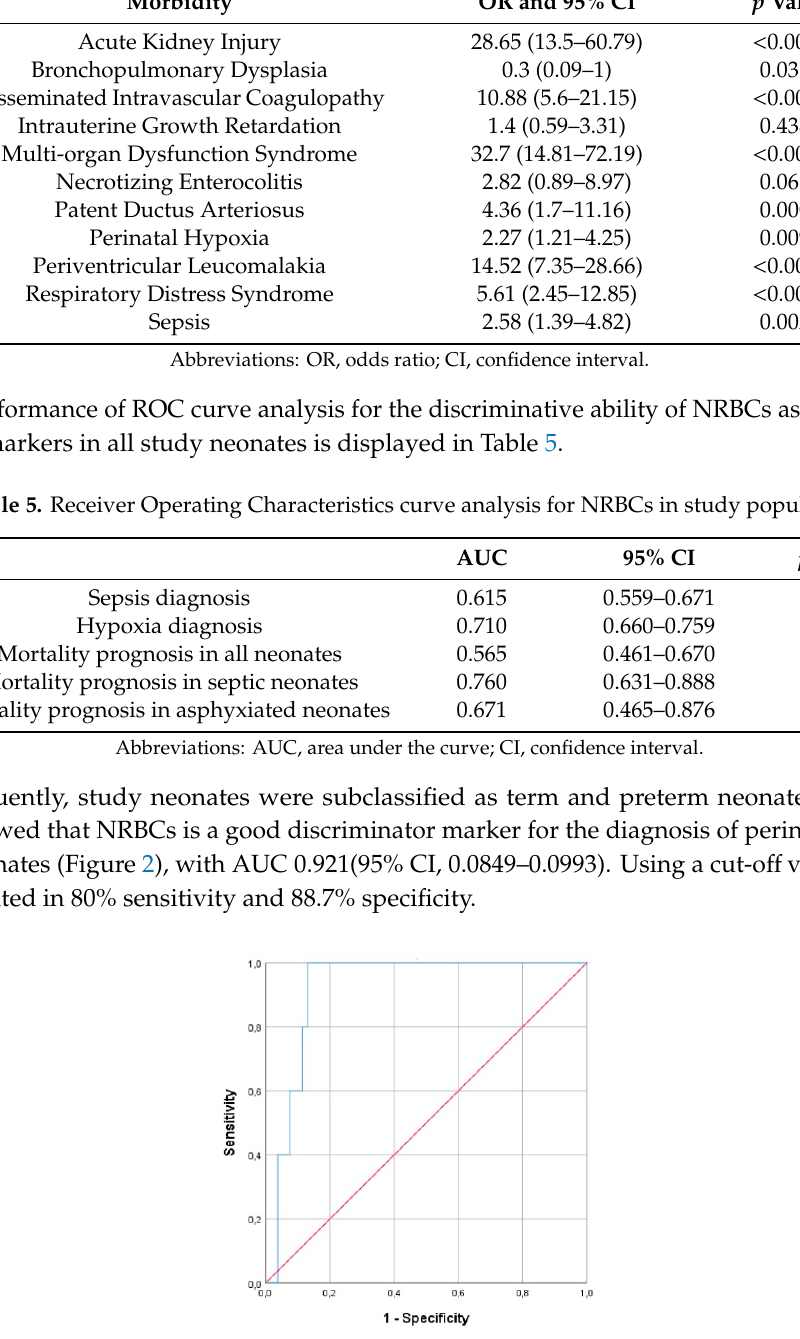
Figure 2. Area under the ROC curves of NRBCs for diagnosis of perinatal hypoxia in critically ill preterm neonates.